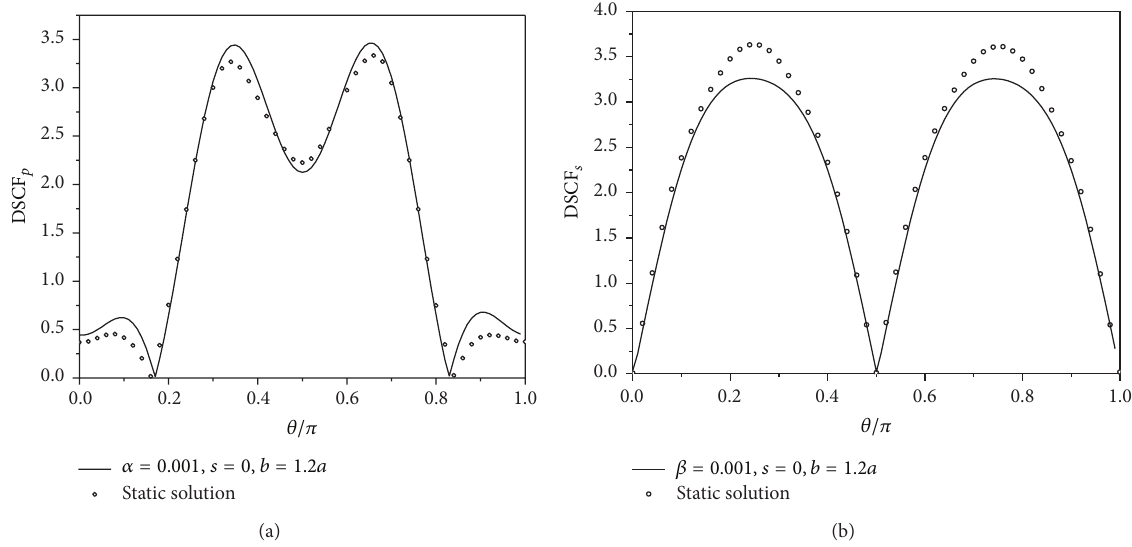
Figure 3: Comparisons of the present numerical results for the DSCF induced by very low frequency incident P-wave and SV-wave with the static solutions.